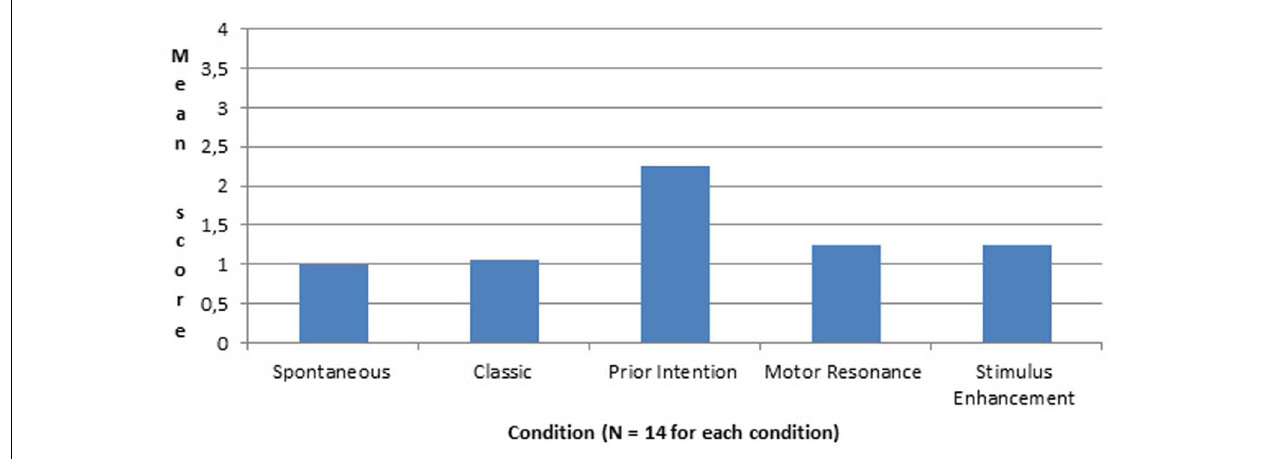
FIGURE 5 | Mean score at the test following demonstration (except for the Spontaneous group) as a function of